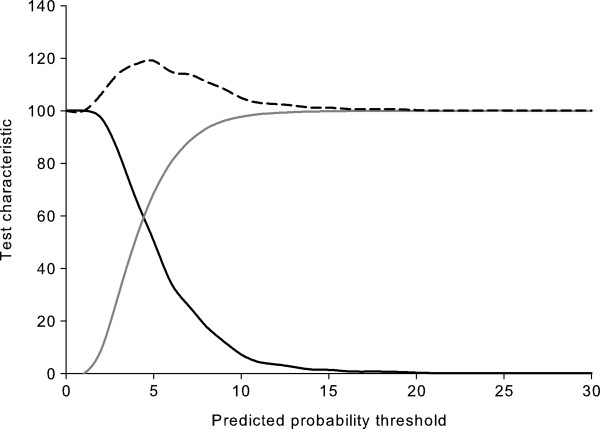
Test characteristics of the unrecognized myocardial infarction basic assessment tool. Sensitivity (solid black line), specificity (solid gray line), and sum of sensitivity and specificity (dashed black line).